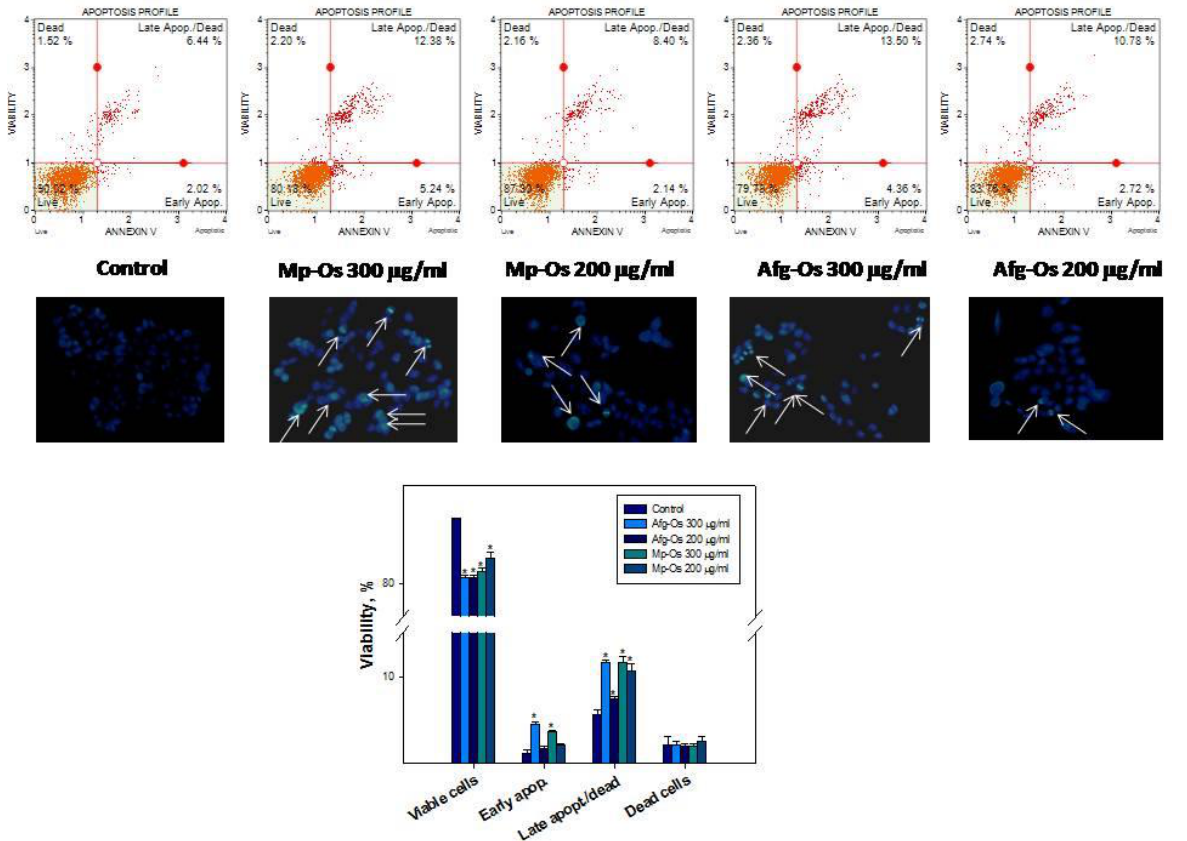
Figure 5. Hoechst 33342 staining showing chromatin condensation and DNA fragmentation in apoptotic cells under treatment of control, Mp-OS 300 and 200 mg/mL and Afg-OS 300 and 200 mg/mL. Arrows indicate nuclei with condensed chromatin. Apoptotic profile (Muse™ Annexin V and Dead Cell Assay) for HCT-116 cells, control, Mp-OS and Afg-OS. In all cases, the profiles were determined 72 h after incubation with substances. Each graph has 4 quadrant markers representing different cellular conditions: upper-left quadrant contains dead cells (dead cells/necrosis), upper-right quadrant contains late apoptotic/dead cells (cells positive for both annexin V and cell death marker 7-AAD), lower left contains live cells and lower right contains early apoptotic cells (cells positive for annexin V only). Data are presented as means ± SEM. * p value < 0.05 considered significant.